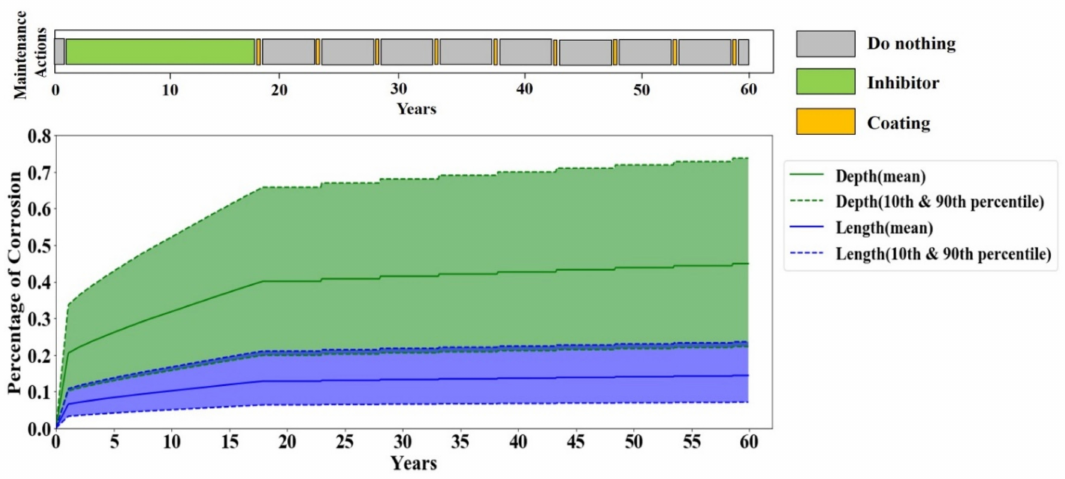
Figure 11. Corrosion depth and length in one 60-year full-life evaluation episode for sensitivity scenario two.